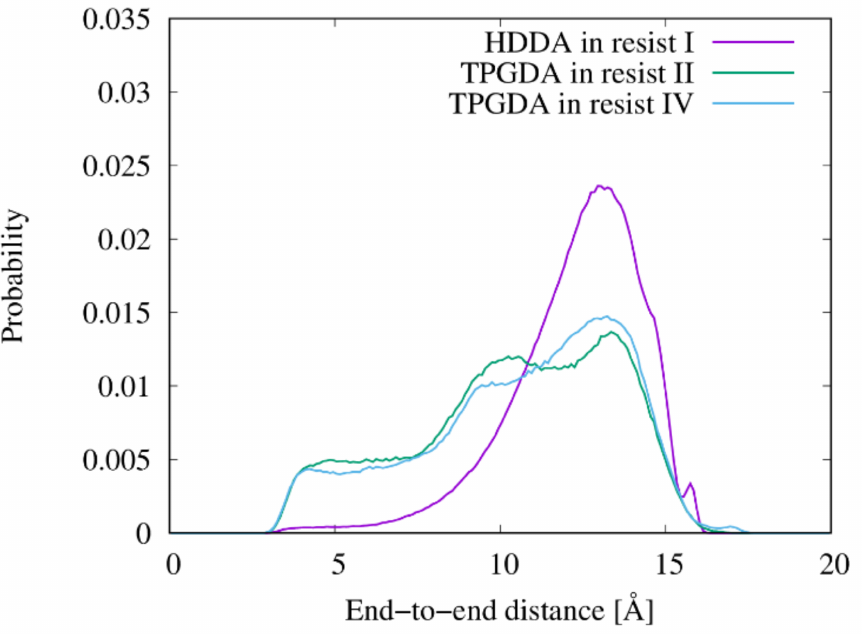
Figure 8. Probability distribution of the end-to-end distance of HDDA in resist I and TPGDA in resists II and